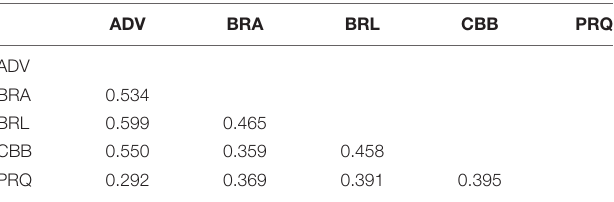
TABLE 4 | Heterotrait-Monotrait ratio (HTMT) criterion.